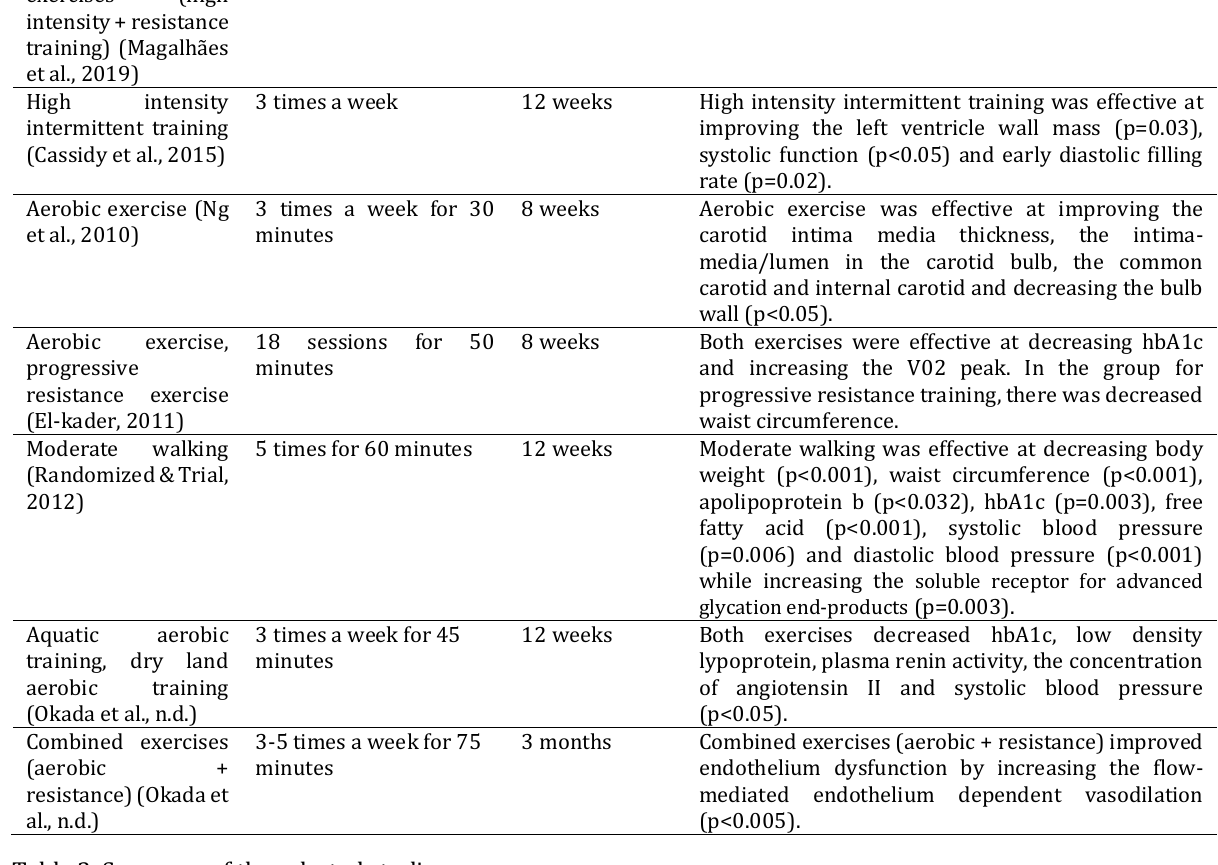
Table 3. Summary of the selected